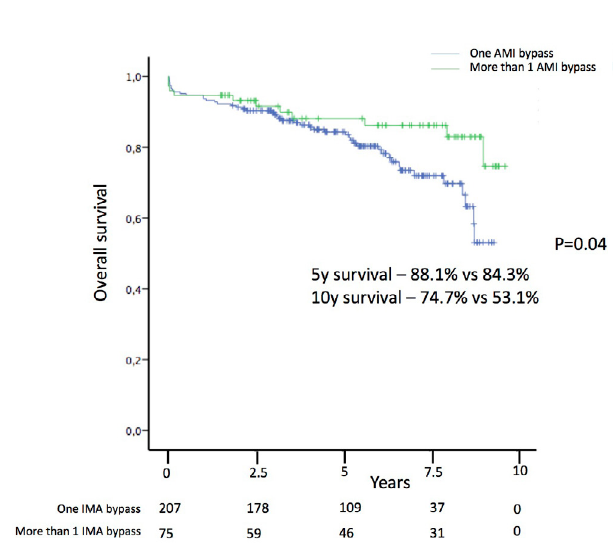
Table 5. Postoperative outcomes of patients who underwent CABG for stable angina (n=282).